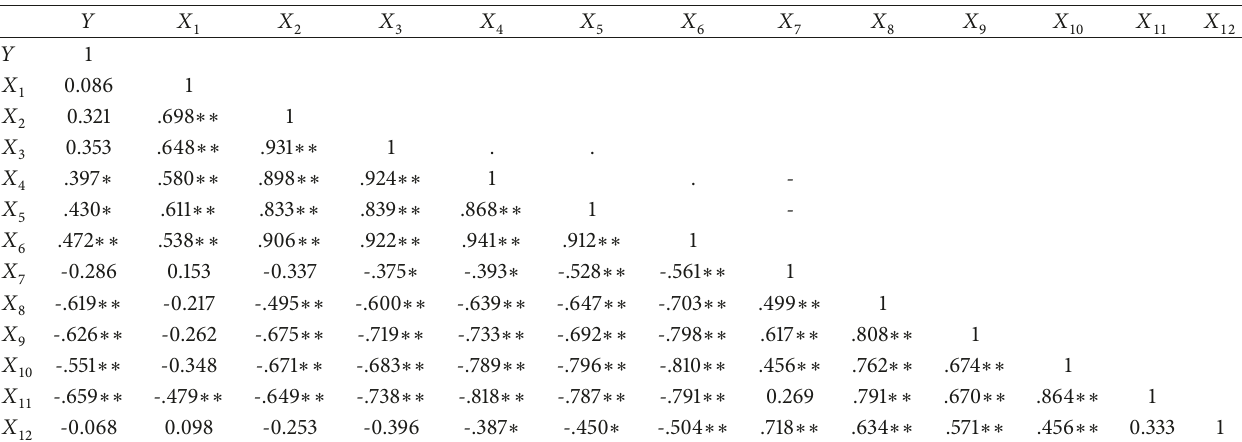
Table 2: Correlation Coefficient.